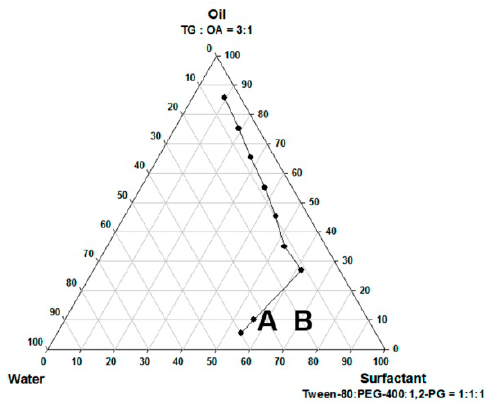
Figure 1. The pseudo-ternary phase diagrams of the microemulsion composed of oils, surfactants, and water. Formulations A and B represent the chosen formulation.